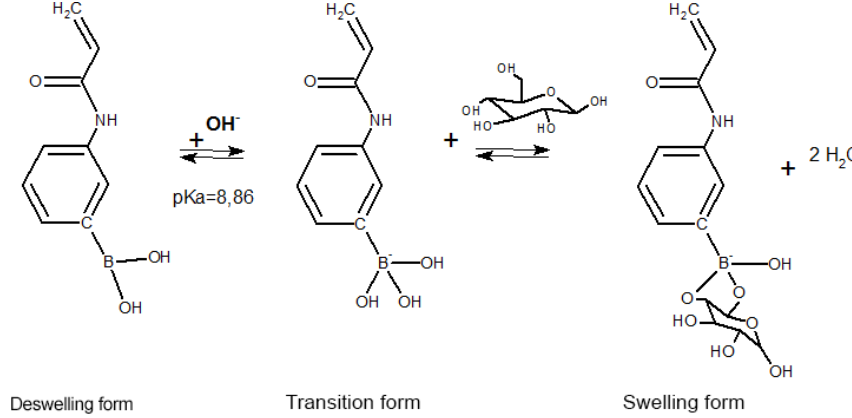
Figure 1. A glucose linkage mechanism of phenylboronic acid acrylamide dependent on the pKa